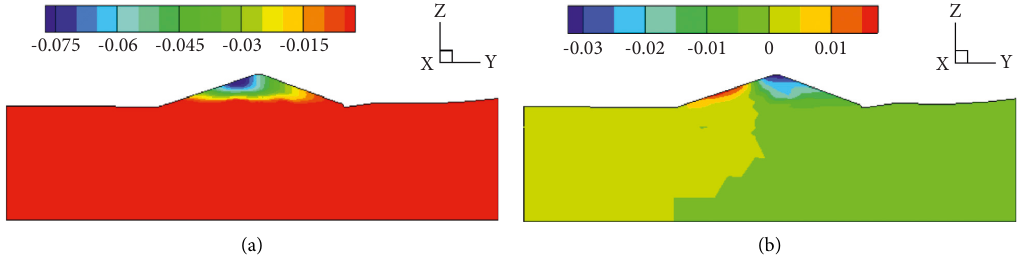
Figure 9: Deformation of dam on the 80th day after the sharp drop in the storage level (m): (a) settlement; (b) lateral displacement.